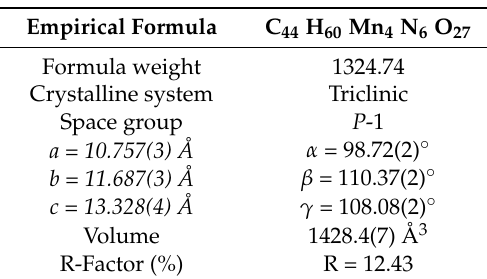
Table 1. Crystallographic Refinement data of 1 .